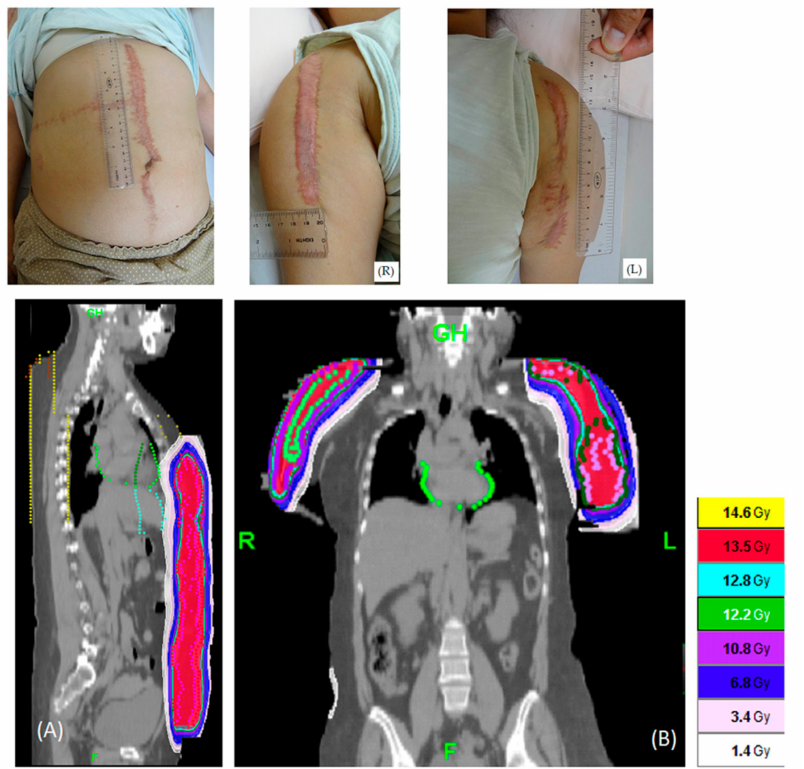
Figure 2. One patient had an extensive keloid caused by a car accident (up three pictures in the figure). She was treated with helical tomography within 24 h after keloid excision with 13.5 Gy in 3 fractions. ( A ) Sagittal view. ( B ) Coronal